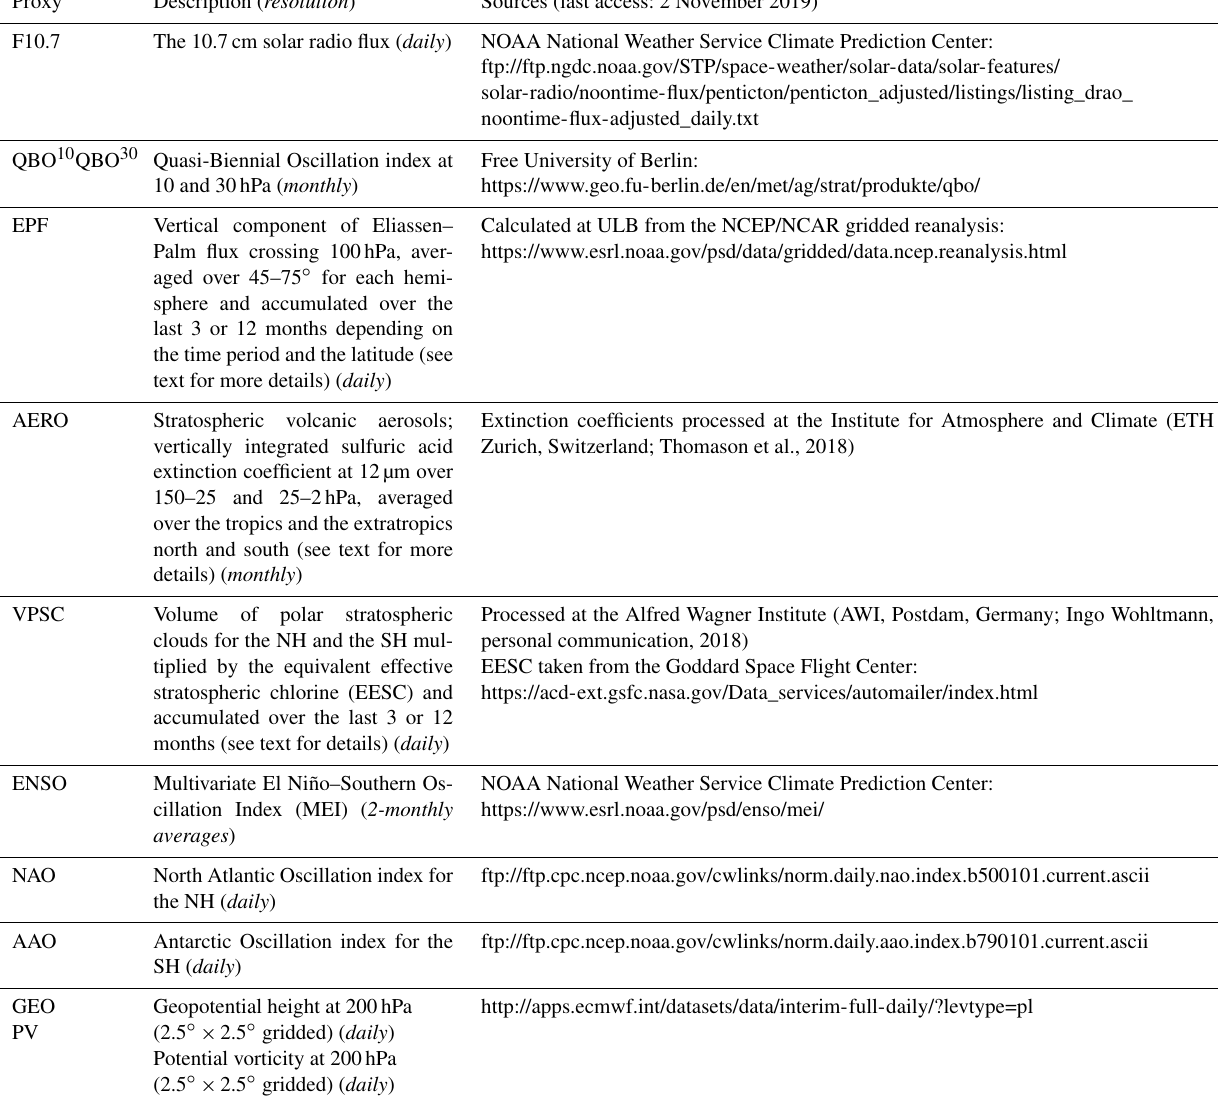
Table 1. List of the explanatory variables used in the multi-linear regression model applied on IASI stratospheric O 3 , their temporal resolution and their